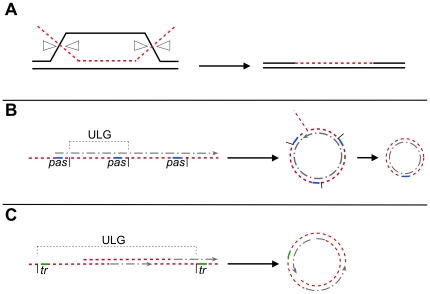
Model for natural transformation with different kinds of DNAs.(A) With chromosomal transformation, the incoming ssDNA (red line) displaces the identical strand in the duplex of chromosomal DNA and pairs with the complementary strand. The D-loop structure is resolved as indicated by white triangles, and the displaced DNA strand degraded. The ends are sealed and one of the daughter cell inherits the donor DNA; (B), with oligomeric plasmid DNA, the incoming ssDNA (red line) is longer than a unit-length plasmid genome (ULG), indicated by vertical bars. Replication initiated at the primosome assembly site (pas, indicated as a blue line), may convert the ssDNA onto dsDNA. After DNA replication, homologous regions must recombine to generate a circular intermediate that is then converted into a single plasmid monomer. (C) With viral DNA, the fragmented viral ssDNA (red line) recombines intermolecularly to generate a ULG after filling-in the gaps. The assembled dsDNA must recombine intramolecularly, probably through the terminal redundancy (tr, depicted in green) to generate a circular molecule.